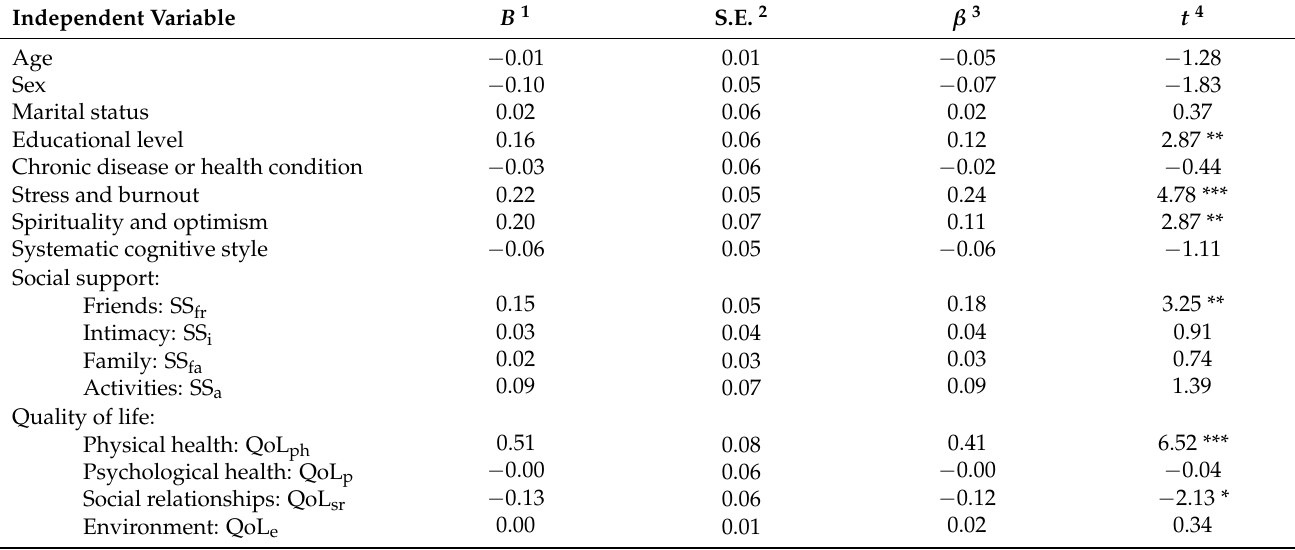
Table 6. Results of a multilinear regression model that was designed using the purpose in life total score as the dependent variable, involving only working